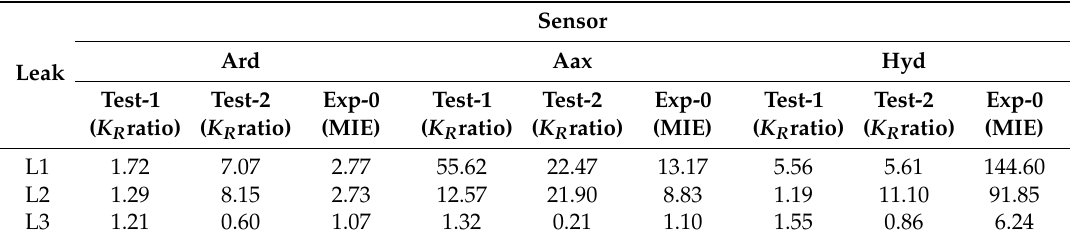
Table 2. Comparison between the K R ratio computed for Test-1 and Test-2 with T = 60 s, and the results of previous experiments